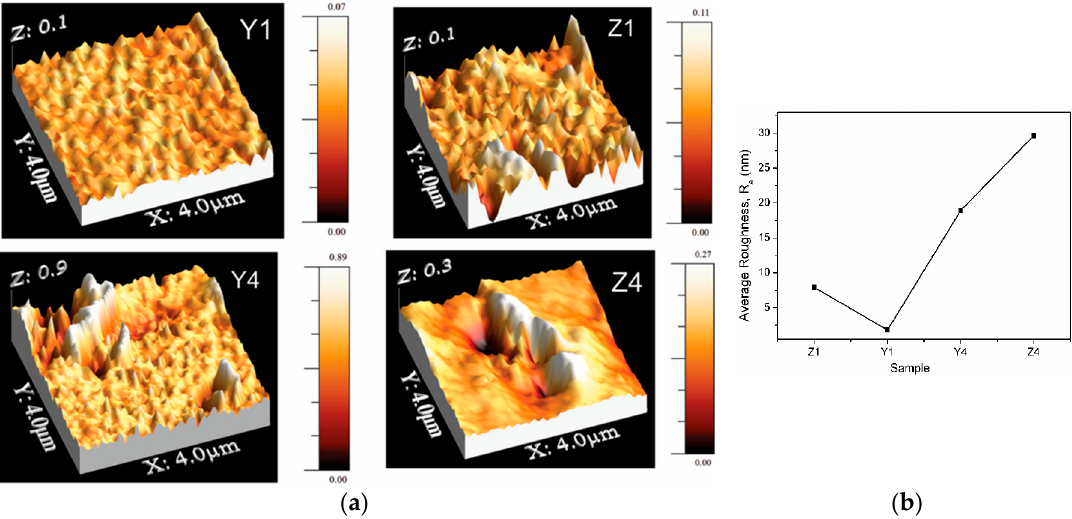
Figure 6. ( a ) 3D-AFM surface topography for the composite membranes, ( b ) Average roughness.